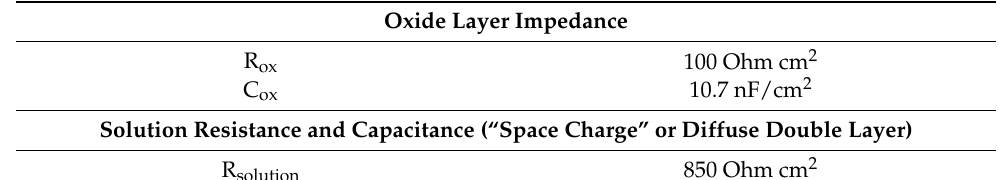
Figure 9. High frequency part of the impedance: oxide layer (blue cross), solution (green dash) and total high frequency impedance (red square).